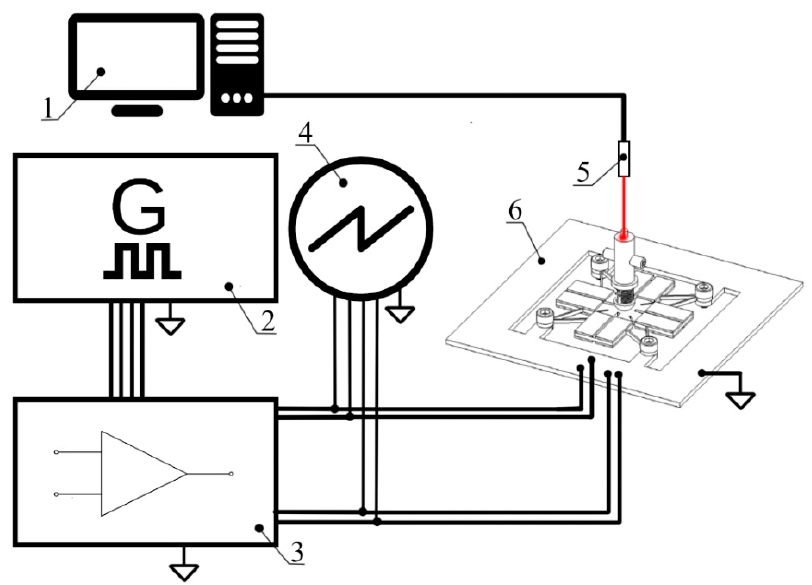
Figure 12. Experimental setup; 1—a computer with data acquisition software; 2—a four-channel function generator; 3—a four-channel power amplifier; 4—oscilloscope; 5—a non-contact tachometer; 6—a prototype of the